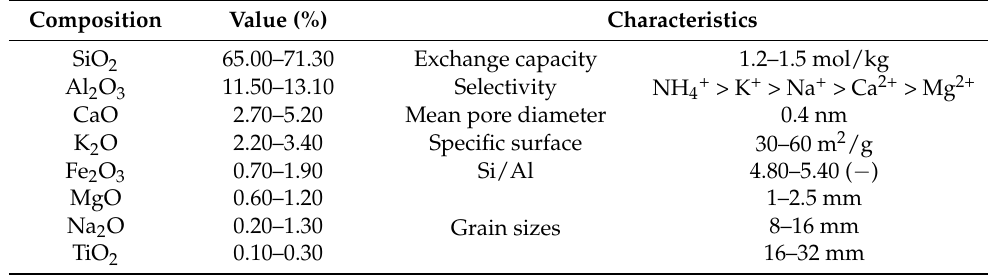
Table 1. Chemical composition and zeolite characteristics, data provided by supplier